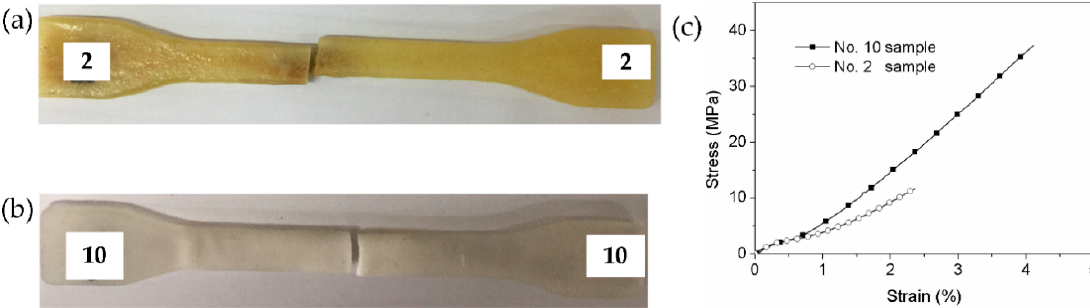
Figure 13. Fractured tensile specimens. ( a ) No. 2 sample; ( b ) No. 10 sample; ( c ) stress–strain curves.